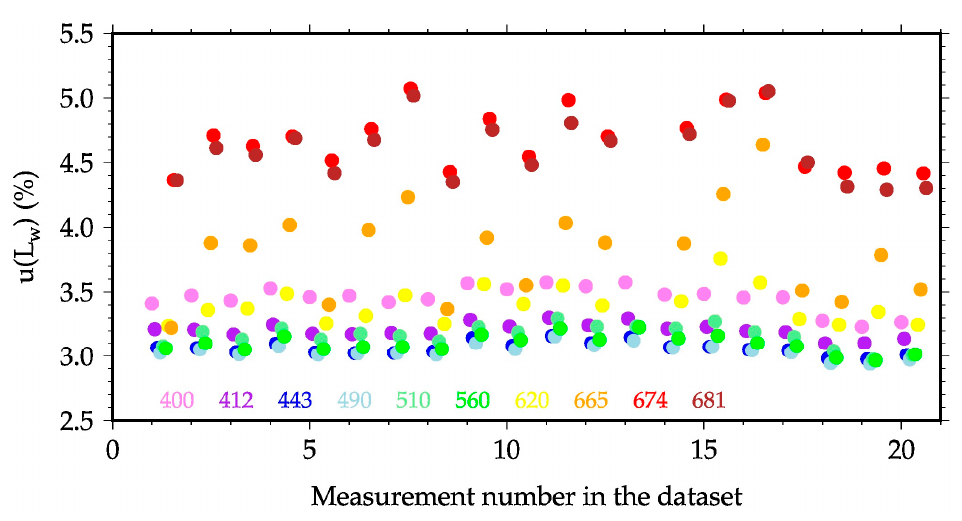
Figure 26. Relative uncertainties ( k = 1) of the water-leaving radiance for 20 measurements (see text). The colour coding for the 10 spectral bands from 400 to 681 nm is indicated at the bottom of the figure. Symbols have been slightly shifted along the horizontal axis for the sake of clarity. Table 7. Relative uncertainties (%, k = 1) in water-leaving radiance for the matchup number 15. OLCI Band (nm) and band (no.)